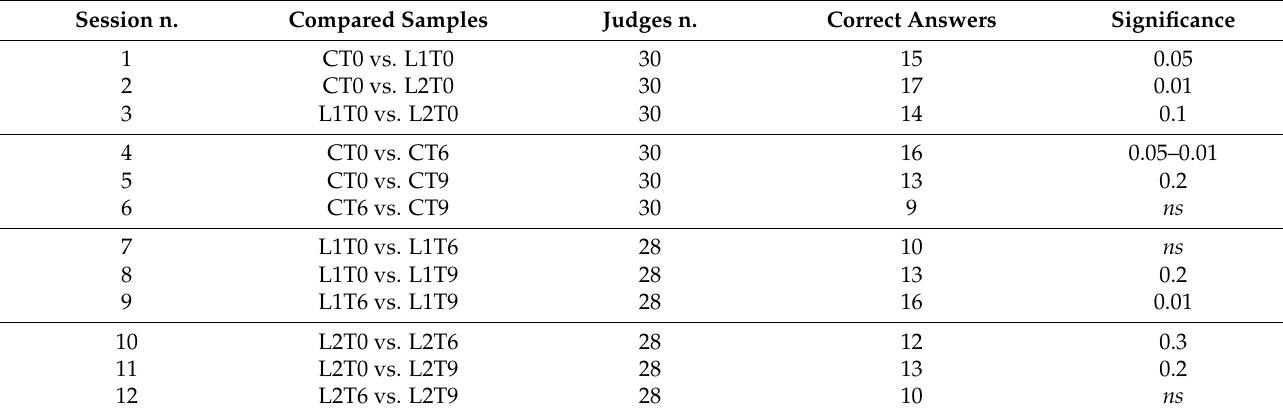
Table 8. Sessions, compared samples, number of subjects involved, number of correct given answers and significance level of the triangle test conducted on hamburger samples (C, Control (minced beef meat + maltodextrine + starter cultures); L1, minced beef meat + starter cultures + 87.5 mg phenols/kg of meat; L2, minced beef meat + starter cultures + 175 phenols/kg of meat) at all the storage times (T0, T6, and